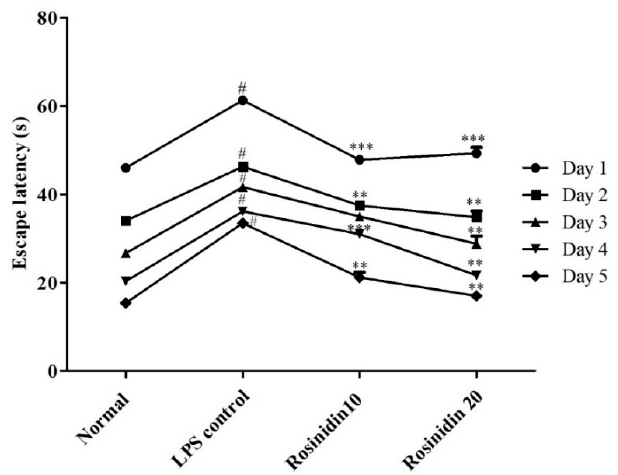
Figure 6. Effect of rosinidin on Morris water maze test in LPS-treated rats. Values are expressed in mean ± S.E.M. (n = 6). # p < 0.05 vs. normal control rats and ** p < 0.01; and *** p < 0.001 vs. LPS control rats. Two-way ANOVA followed by Bonferroni post hoc test.